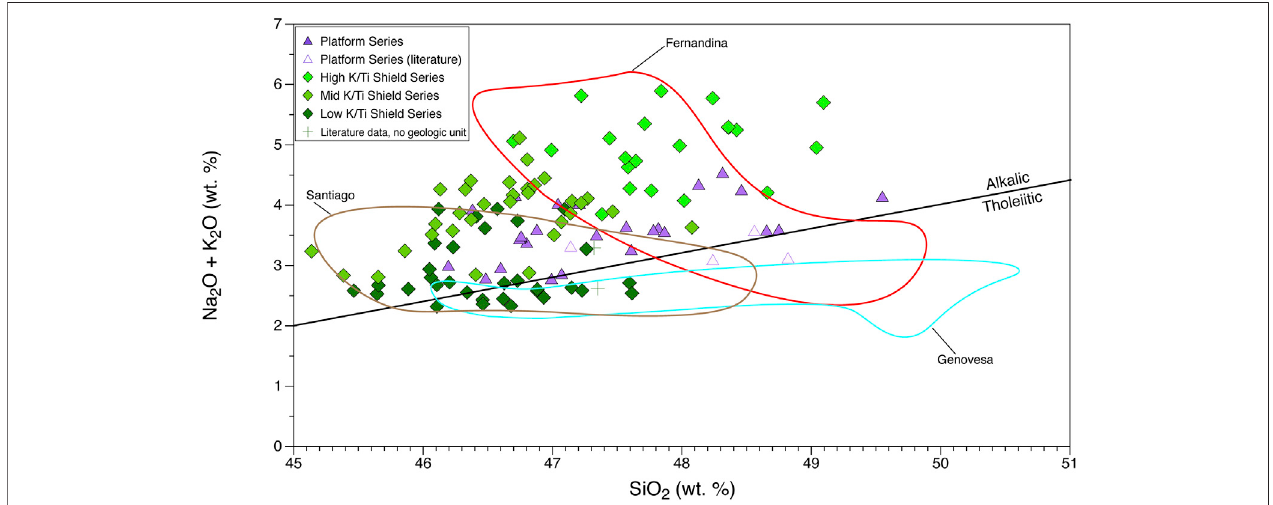
FIGURE 2 | Alkali-silica diagram of Santa Cruz lavas. The alkalic-tholeiitic dividing line is from Macdonald and Katsura, 1964). Fields are literature data. Red: Fernandina, blue: Genovesa, brown: Santiago (White et al., 1993; Harpp et al., 2002; Harpp et al., 2003; Saal et al., 2007; Gibson and Geist, 2010; Gibson et al., 2012; Harpp et al., 2014a). Samples indicated by a cross are literature data from Santa Cruz (White et al., 1993; Kurz and Geist, 1999; Saal et al., 2007); they have not been attributed to either the Platform or Shield Series owing to a lack of GPS coordinates for their origin locations.